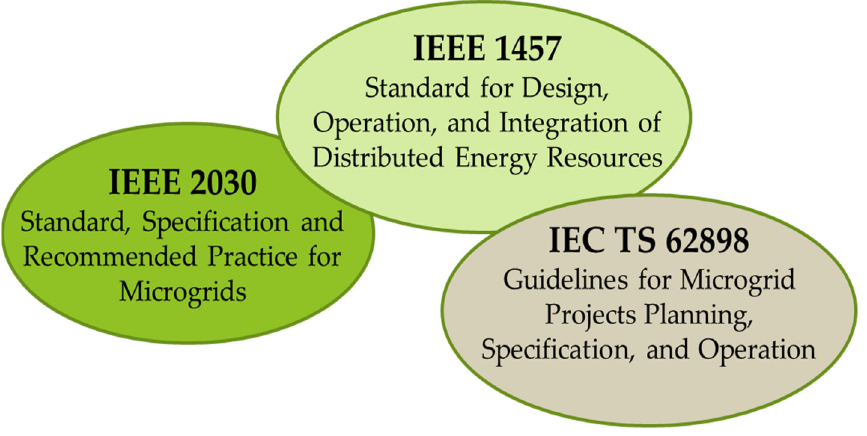
Figure 1. Standards for microgrids.